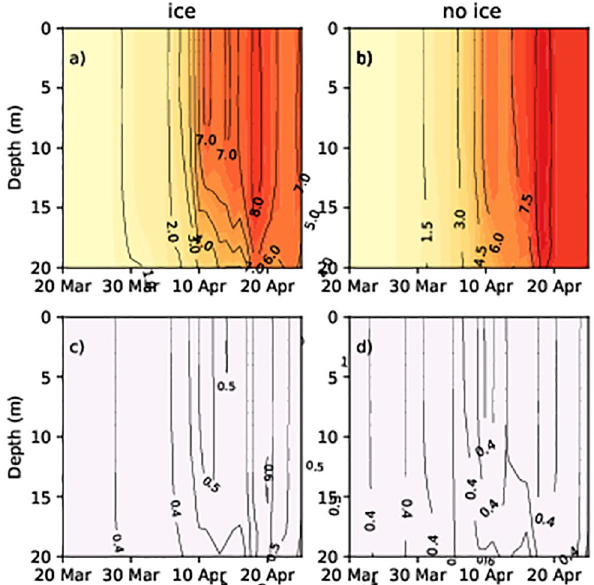
tions in the northern part affects the state of the wider Baltic Sea.